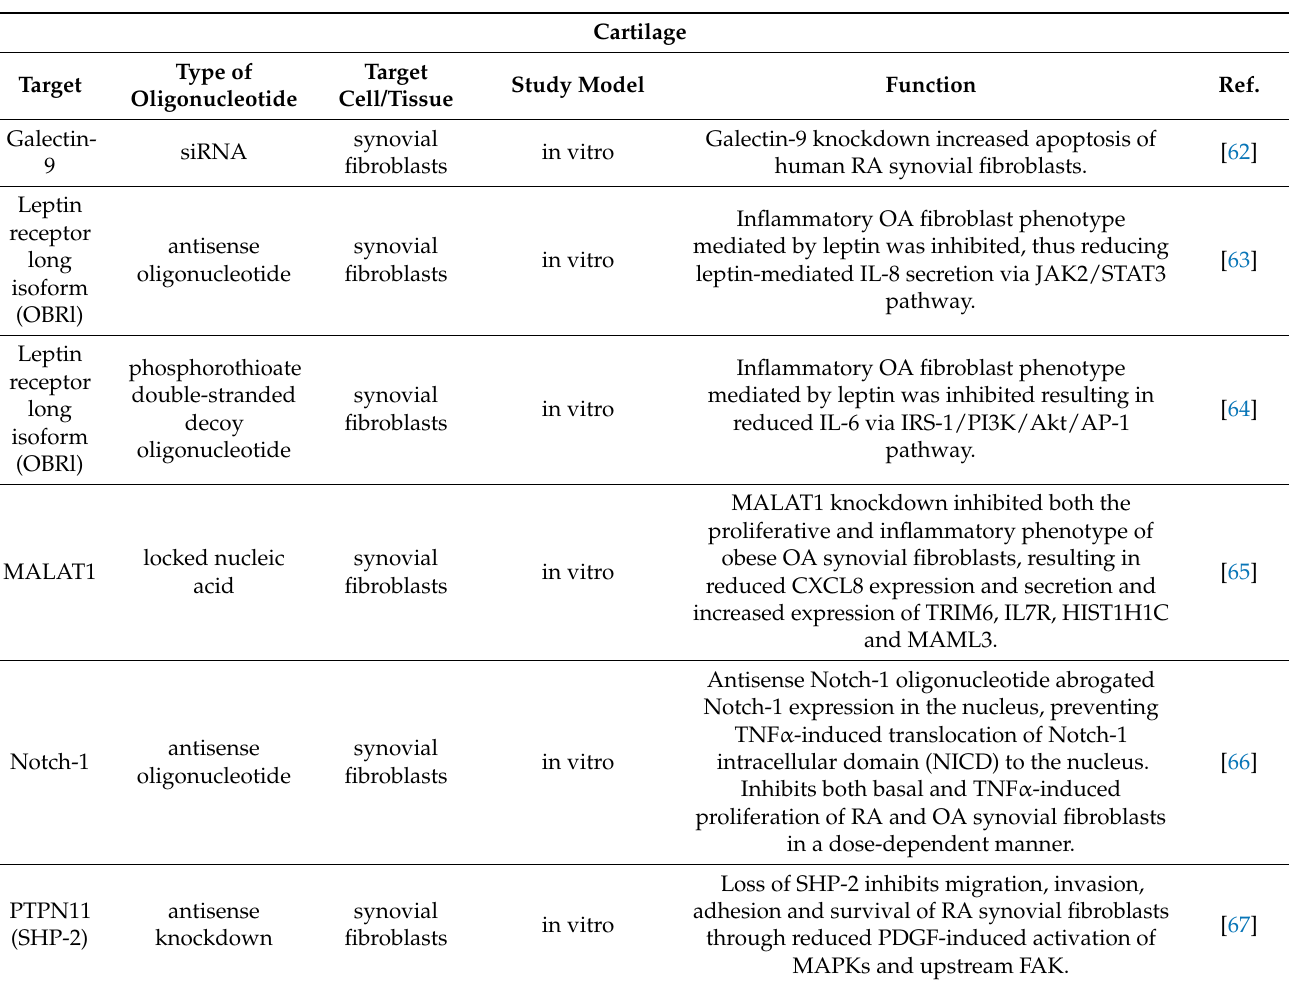
Table 1. Cont. Cartilage